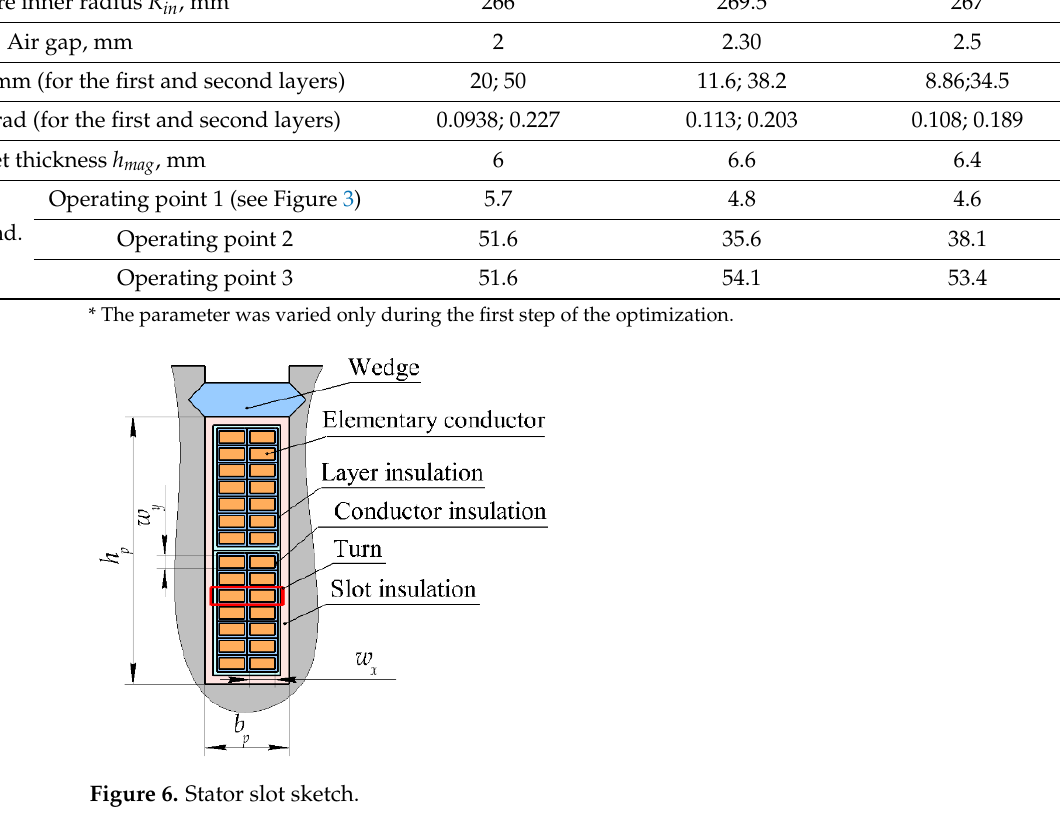
Table 2. IPMSM parameters fixed during the optimization.